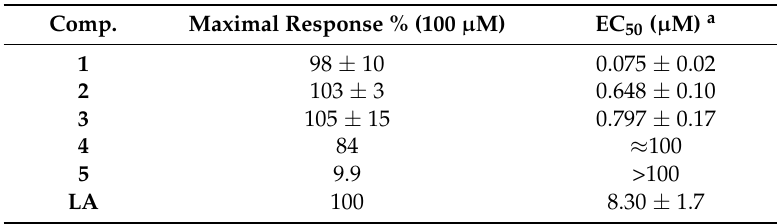
Table 1. Preliminary screening (Efficacy, maximal response) and GPR40 agonistic activities (Potency, EC 50 ) of compounds 1 – 5 in calcium assay for hGPR40/G α 16/HEK293. Comp.